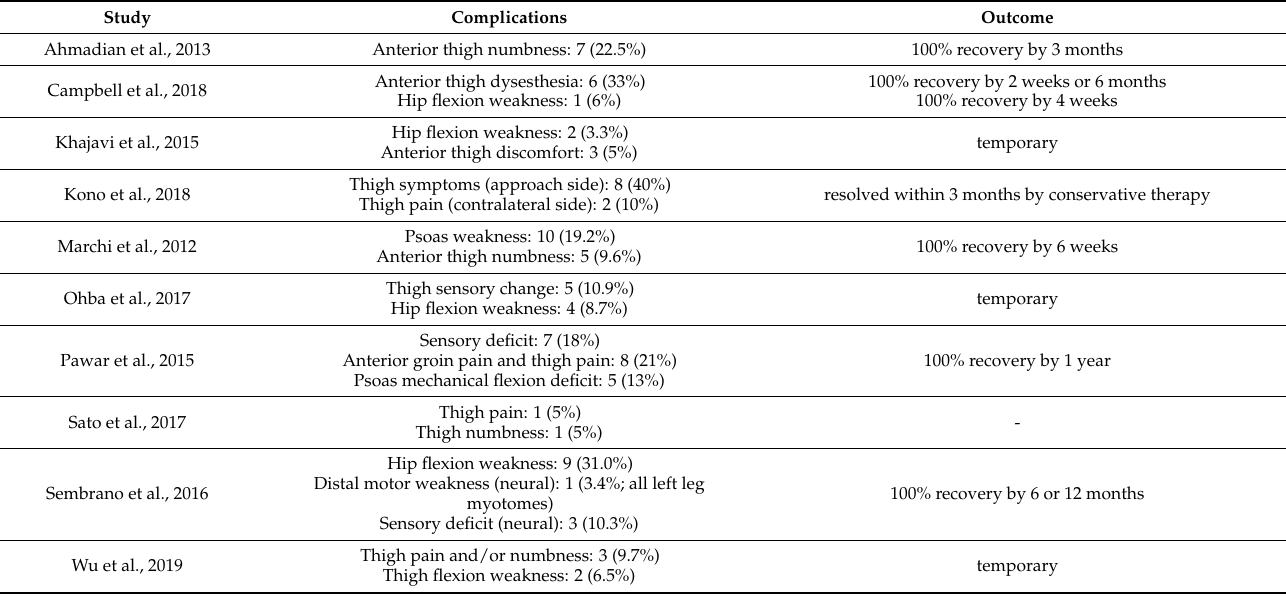
Table 6. Postoperative